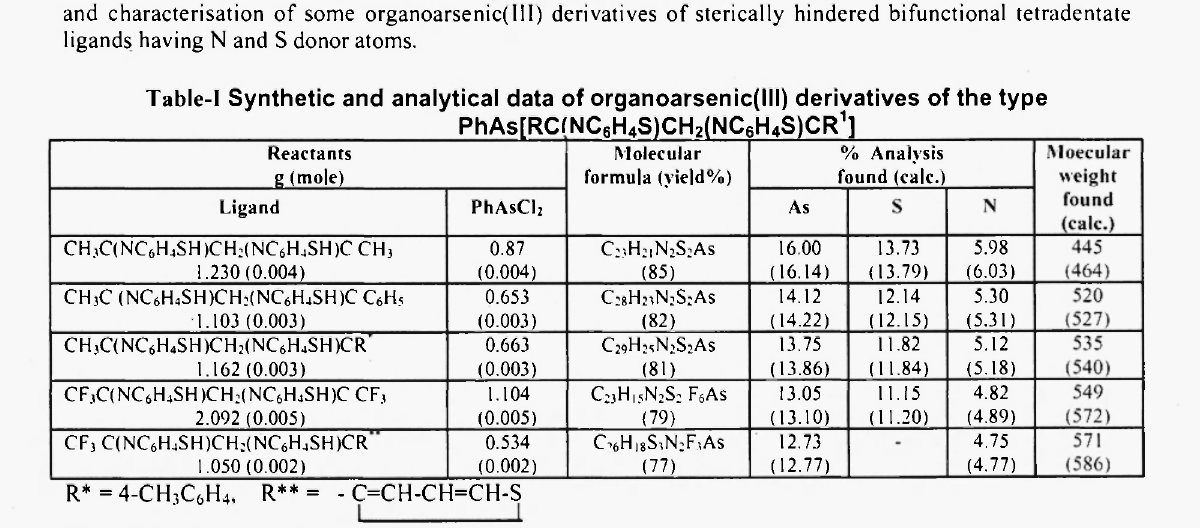
Table-1 Synthetic and analytical data of organoarsenic(lll) derivatives of the